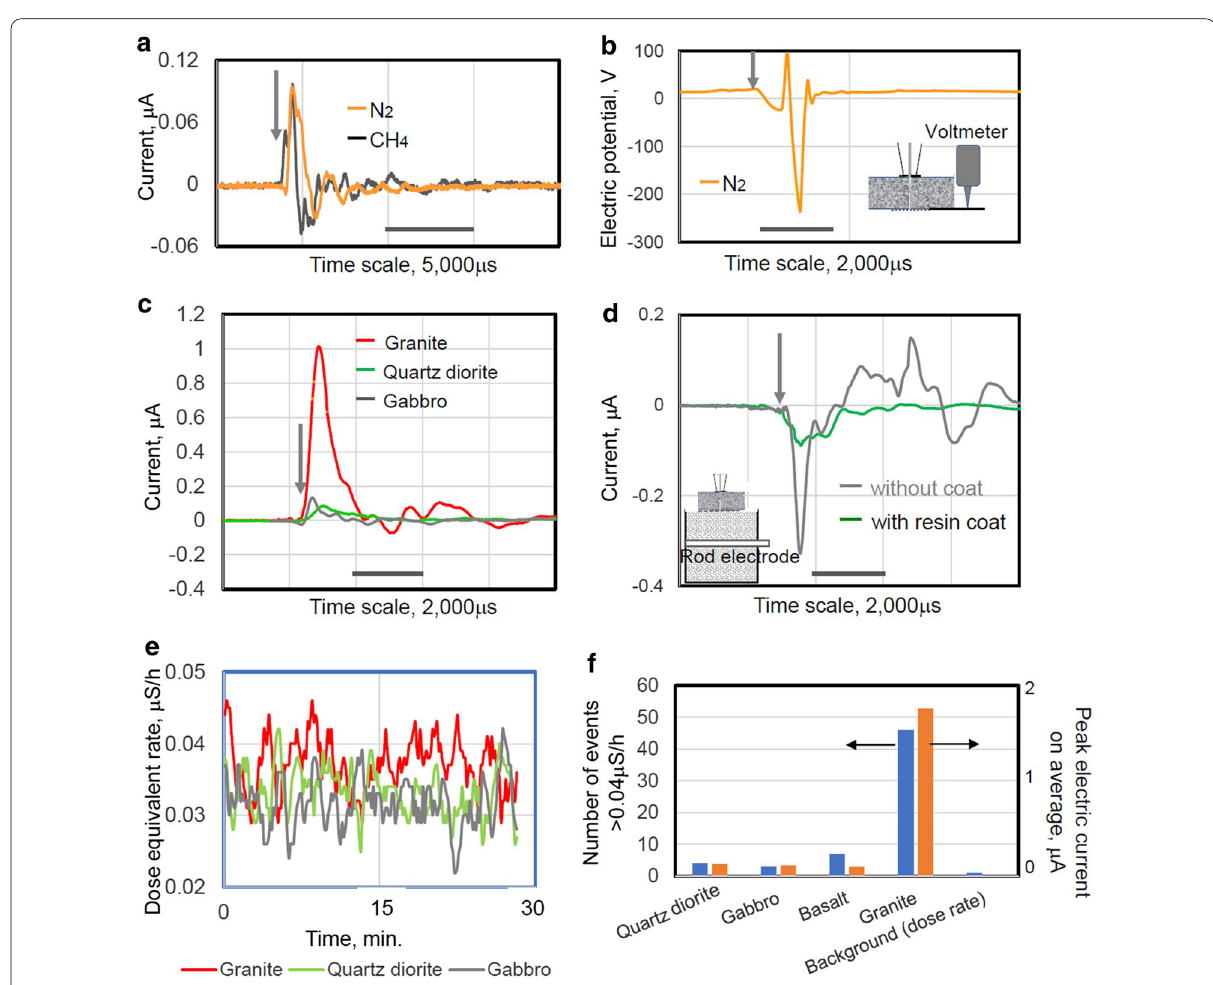
Fig. 3 a and b Typical results for third series of experiments. a Currents for combination of gabbro/CH 4 or N 2 at ~ 160 °C, which are enlarged the signals in the middle of Fig. 2e; b electric potential for gabbro/N 2 at ~ 160 °C. c and d Typical results for fourth series of experiments. c Current and vibration for combination of granite/CO 2 at ~ 25 °C and d induced current signals at the pipe electrode with and without non-conductive resin coating buried in a container filled with granite grains and soil. Arrows show in a – d the final rupture point when the gas started to flow in the crack gap. e Gamma-ray equivalent dose rate for granite, gabbro, and quartz diorite in 30-min measurements. f Comparison number Nγ >0.04 of events for the γ-ray equivalent dose rate greater than 0.04 μSv/h and average peak currents for several test runs of quartz diorite, gabbro, basalt, and granite with CO 2 at S 1.2 10 –4 m 2 and ~ 25 °C; Nγ >0.04 for the background in open air is also included. Arrows pointing to the left and right indicate the = × vertical axis showing the units of the blue and orange bar